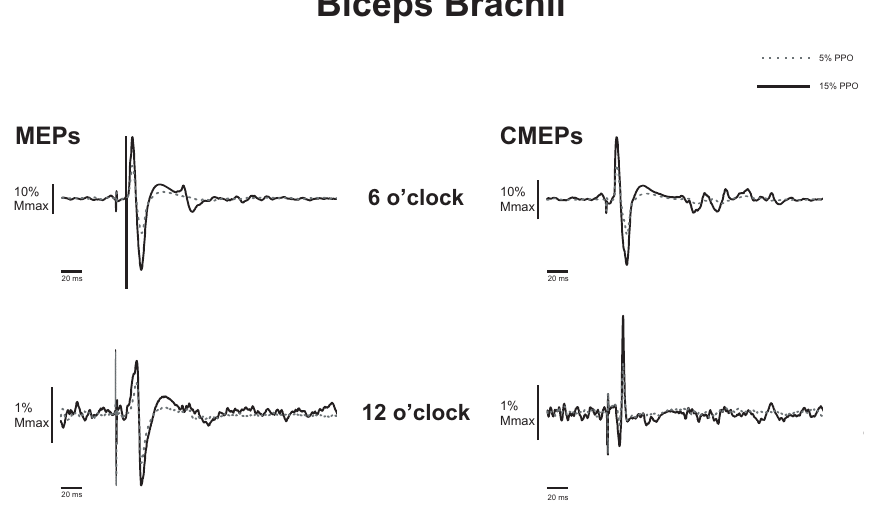
Figure 2. Biceps brachii representative example ( n = 1). Average motor evoked potentials (MEPs; left panel) and cervicomedullary evoked potential (CMEPs; right panel) traces following eight stimulations during arm cycling at 5% PPO (dashed gray line), and 15% PPO (solid black line) at the 6 o’clock ( top panels) and 12 o’clock ( bottom panels) positions. Amplitudes are expressed as a percentage of maximal M-wave (M max ).